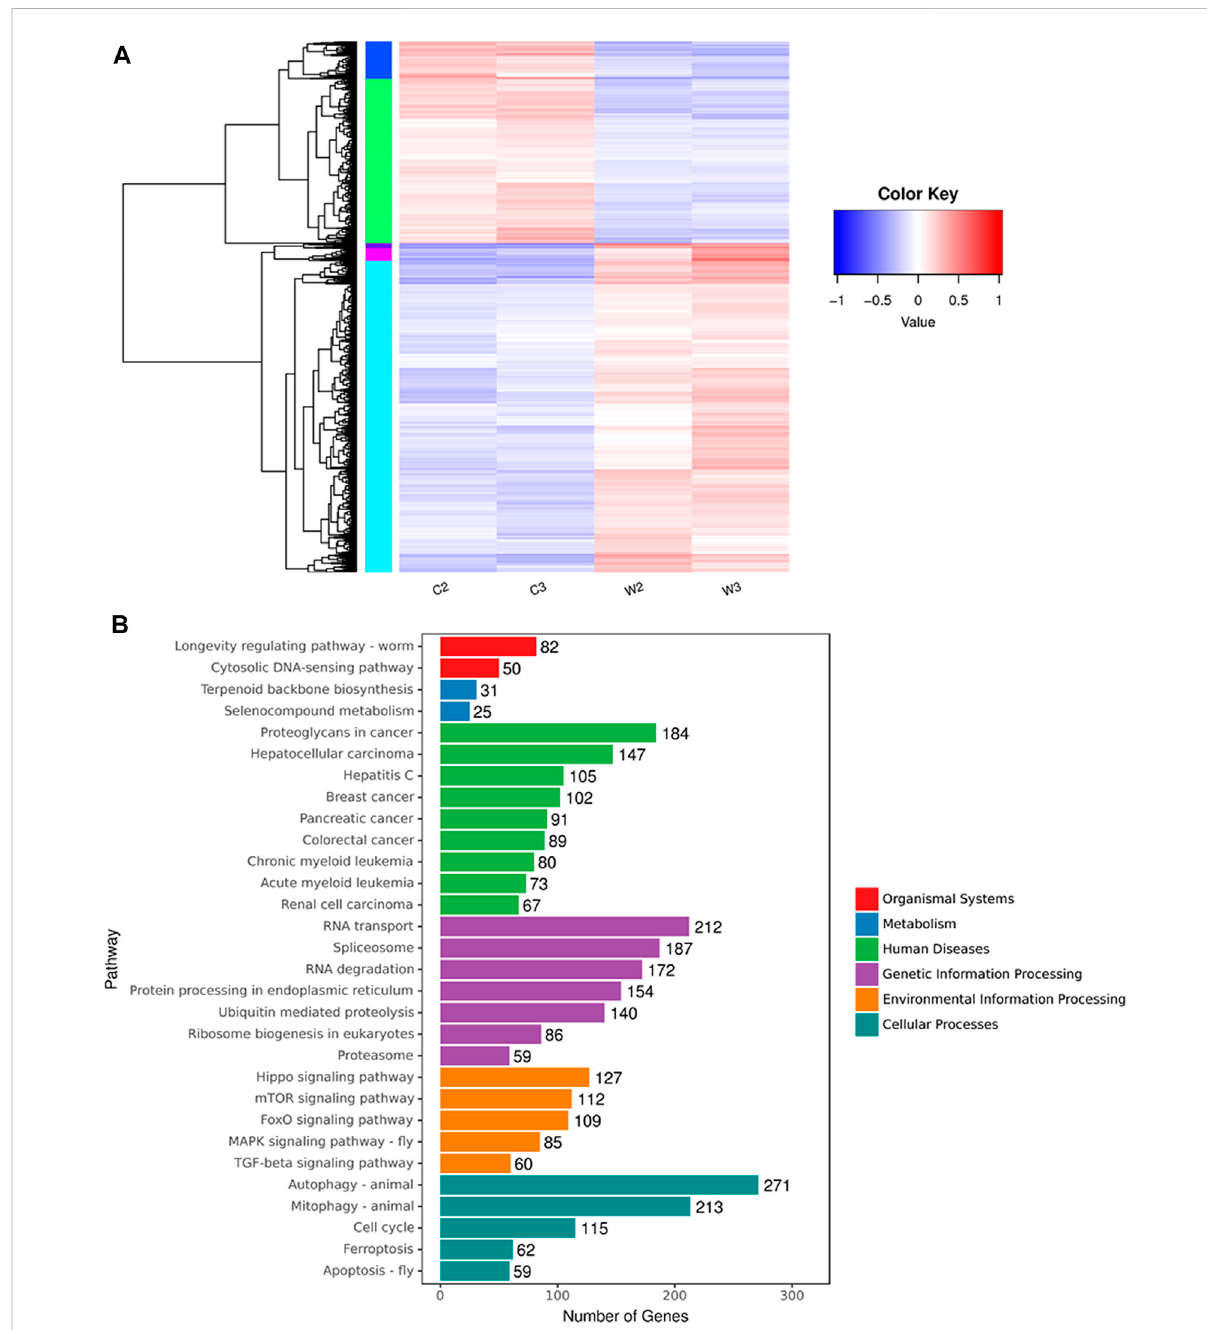
FIGURE 1 Cluster analysis and KEGG pathway enrichment of differential expressed genes between WGM extracts-treated and control groups in Hep3B cells. Cells were treated with vehicle alone or with 150 μ g/ml WGM extracts for 24 h. (A) Cluster analysis of differential expressed genes between the WGM extracts-treated and control groups. The regions of different colors represent different clusters. The color scale of the heatmap illustrates the log 2 of fold change of the WGM extracts-treated/control samples shown in the heatmap. (B) The KEGG pathway enrichments of the DEGs between WGM extracts-treated and control samples. The y-axis shows the names of the enriched pathways. The results were analyzed to determine genes with signi fi cant differential expression according to the criteria of fold change greater than 2 and FDR less than